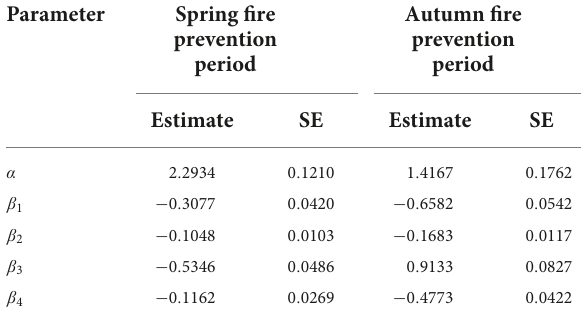
TABLE 2 Parameter estimation based on the logistic regression